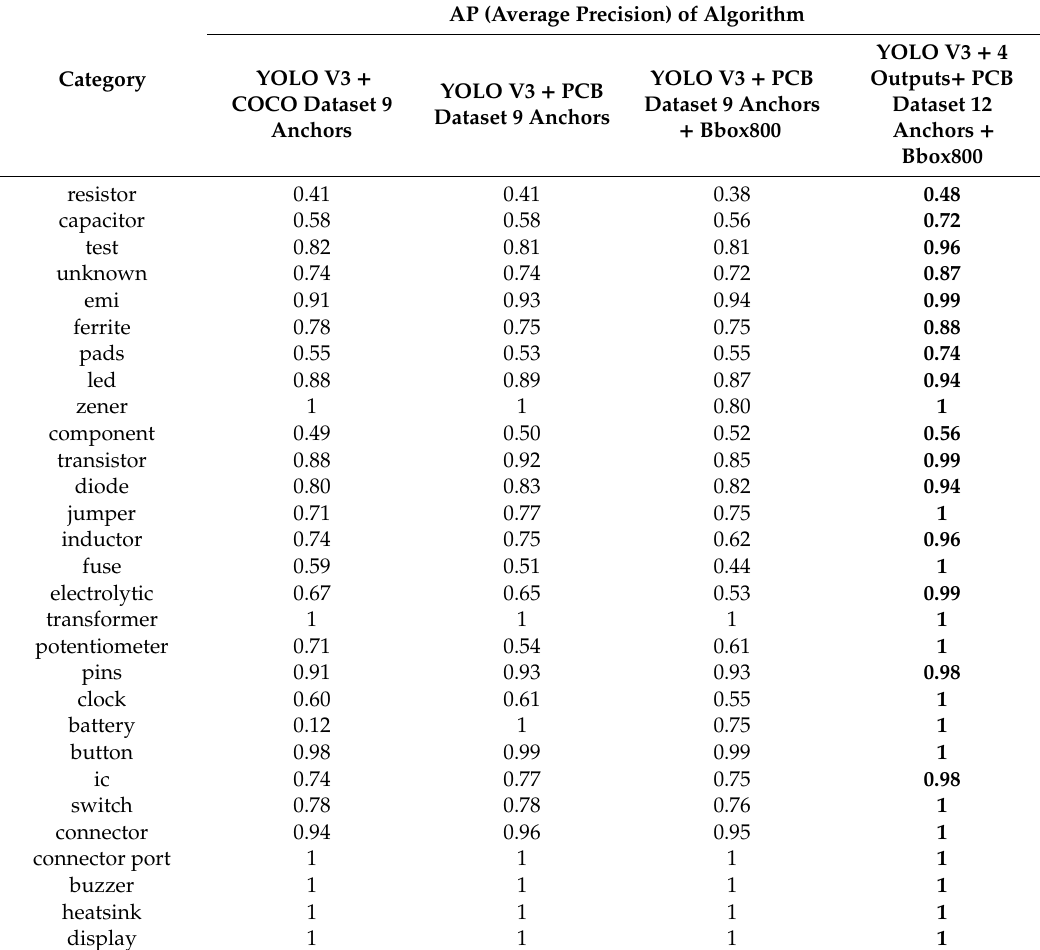
Table 4. AP for each electronic component category of four